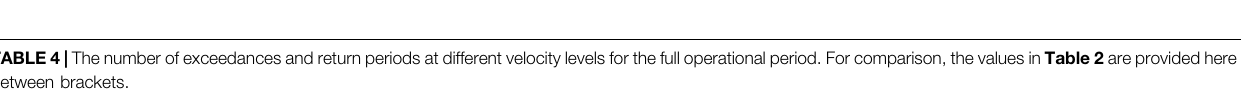
FIGURE 8 | Complementary cumulative distribution functions of the 254 one-year heartbeat datasets.